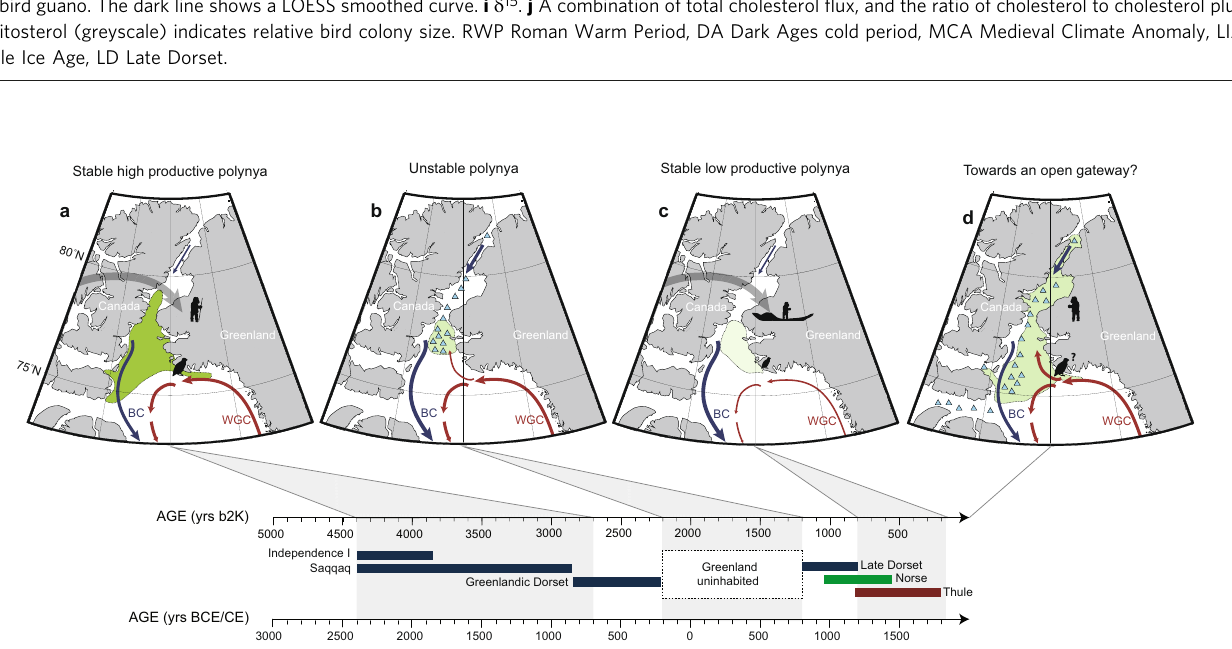
Fig. 5 Evolution of the North Water ecosystem and cultural transitions in Greenland. a A stable and highly productive polynya is inferred from our records after 4400 – 4200 cal yrs b2k, coincident with the arrival of the fi rst humans in Greenland and the fi rst appearance and expansion of little auks in the area. b From 2700 to 800cal yrs b2k, the polynya is unstable and reduced in extent, particularly after 2200 cal yrs b2k. This period spans a void in the human settlement of Greenland from c . 2200 – 1200 yrs b2k and absence/low abundance of little auks. c From c. 800 cal yrs b2k, a stable but low productive polynya is inferred and little auk colonies recover. During this time, there is a replacement of Late Dorset groups by the Thule Culture, the direct ancestors of modern Inuit. d Predicted disappearance of the polynya following the current trajectory of Arctic warming and sea-ice decline. BC Baf fi n Current, WGC West Greenland Current. Changes in WGC in fl uence in the polynya region are based on ref. 49 . Triangles represent drift ice. Shades of green represent the interpreted late-spring relative extent and productivity of the polynya (darker green corresponds to a more productive polynya and vice-versa). Background map fi gures were created using Ocean Data View 73 indicates a signi fi cant decline in the abundance of little auks, culminating in a short-lived abandonment of the colony c. 2300